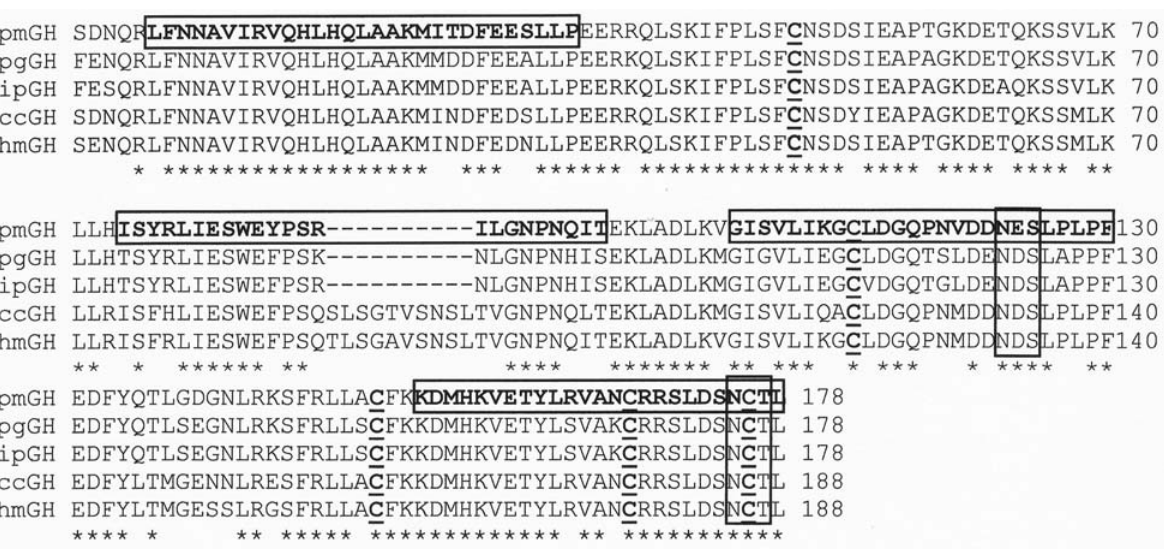
Figure1 -Comparisonof Piaractusmesopotamicus ( pmGH )aminoacidsequencetotwoothersiluriformspecies( pgGH of Pangasianodongigas ,thegi- ant catfish and ipGH of Ictalurus punctatus , the channel catfish) and two cypriniform species ( ccGH of Cyprinus carpio , the common carp and hmGH of Hypophthalamichthys molitrix , the silver carp). A ten amino acid deletion in pmGH, pgGH and ipGH is shown. The conserved Cysteine residues are un- derlined.Verticalboxesindicatepotential N